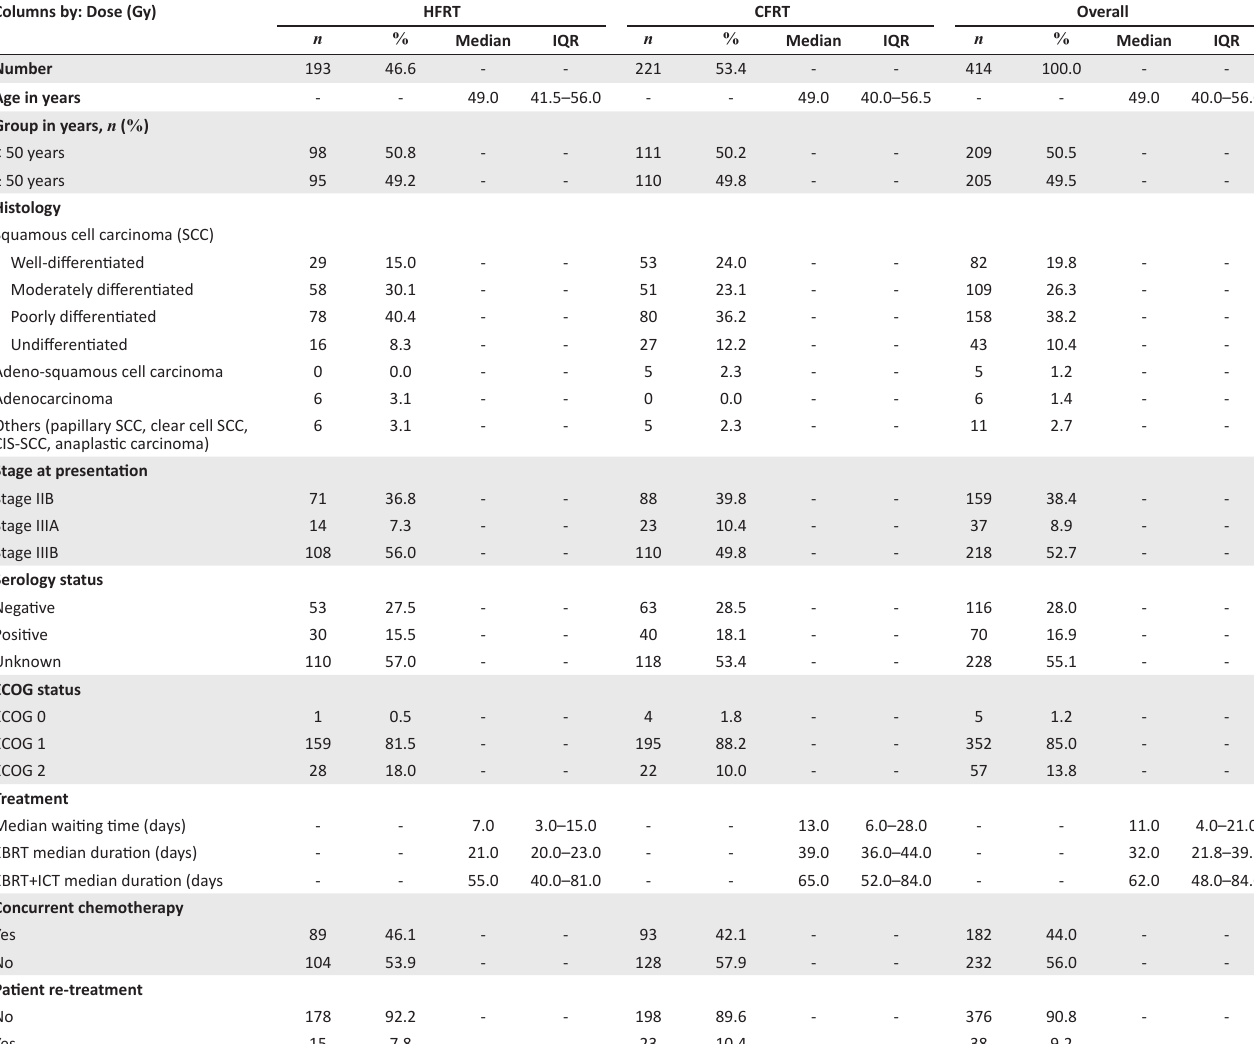
TABLE 1: Clinical and pathological characteristics of all included patients in the review. Columns by: Dose